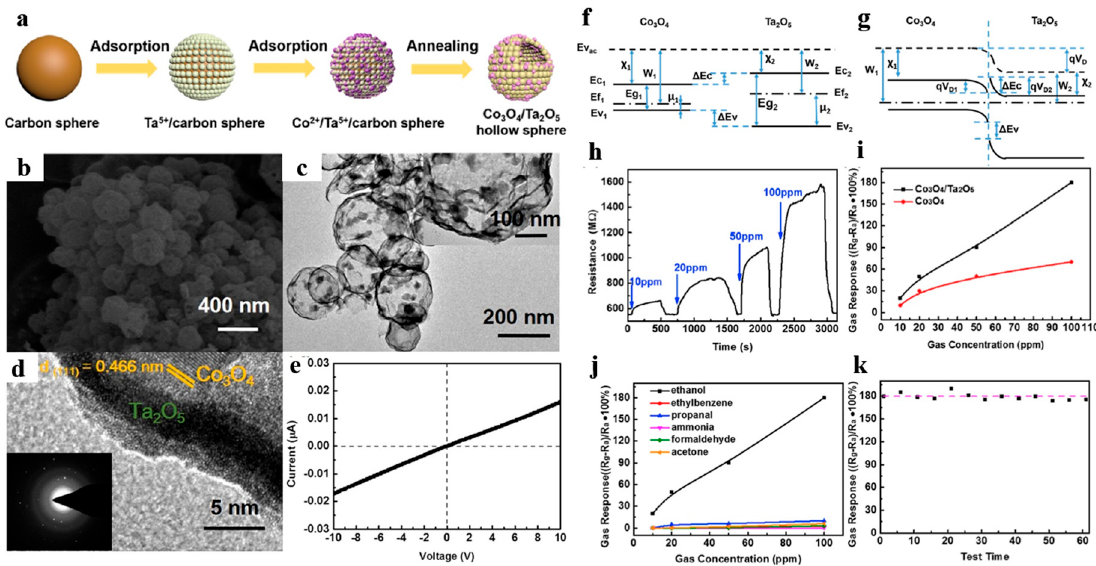
Figure 20. ( a ) Synthetic schematic of Co 3 O 4 /Ta 2 O 5 heterostructure hollow nanospheres, ( b ) FESEM images, ( c ) TEM images, ( d ) HRTEM images. ( e ) I–V characteristics of the Co 3 O 4 /Ta 2 O 5 sensor. Proposed energy band diagram: ( f ) before contact, ( g ) after contact. ( h ) Response and recovery curves of the Co 3 O 4 /Ta 2 O 5 sensor at room temperature. ( i ) Sensitivity curves between the heterostructure and pure Co 3 O 4 sensor with 10–100 ppm. ( j ) Selective test to several reducing gases with concentration of 10–100 ppm. ( k ) Long-term stability test during two months. Reproduced with permission from [111]. Copyright Elsevier, 2017.